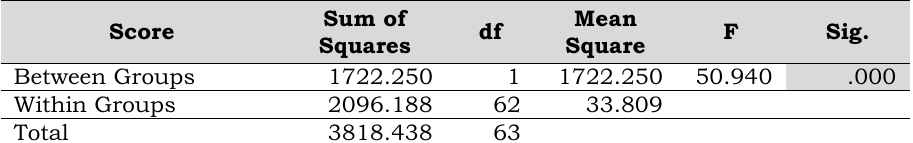
Table 5. The result of ANOVA